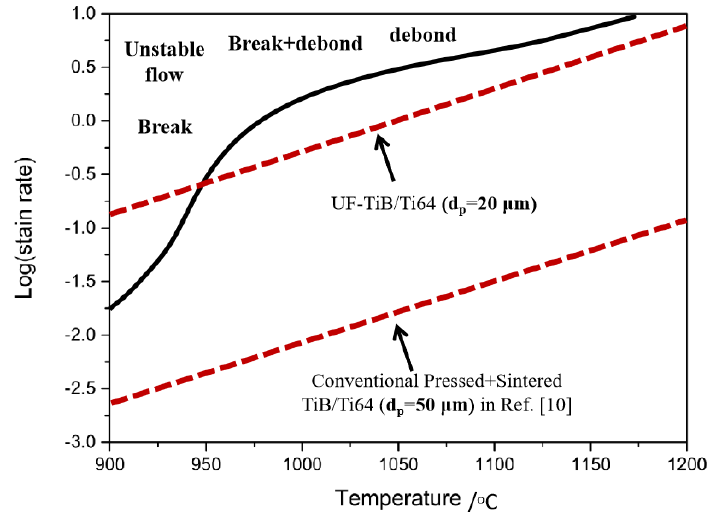
Figure 8. Instability map for hot working of the UF-TiB/Ti-6Al-4V composite. The critical strain rates for p = 16 μm of this UF-TiB/Ti-6Al-4V composite, and for p = 50 μm of the conventional pressed + sintered TiB/Ti-6Al-4V composite in Ref. [10].